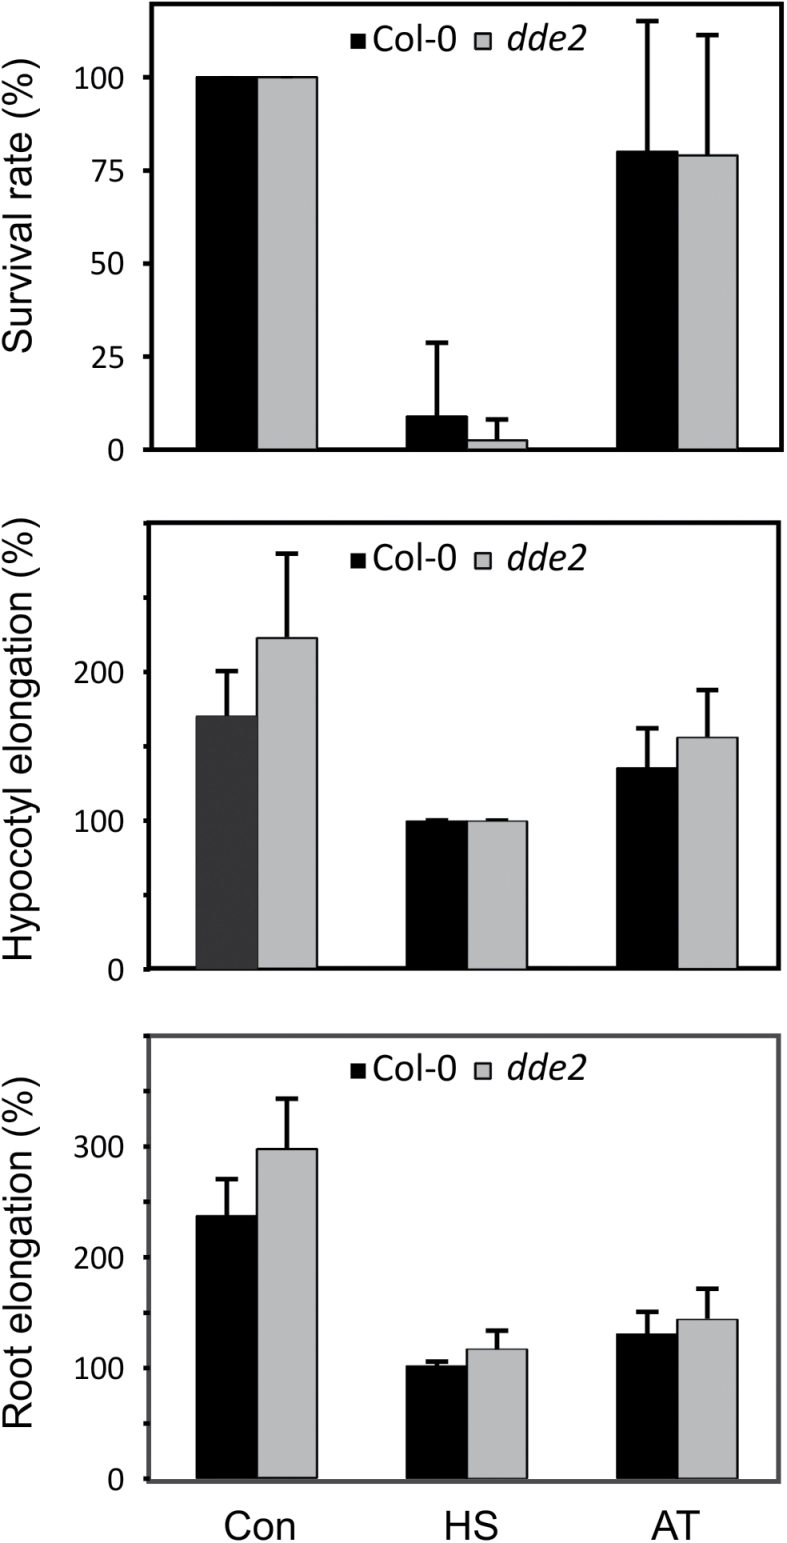
Standard acquired thermotolerance assays. Wild-type (black bars) and dde2 mutant (grey bars) seedlings were grown on agar plates at 22 °C. Seedlings were left at 22 °C (Con), treated with a heat shock at 45 °C for 2 h without prior acclimation (HS) or pretreated at 37 °C for 2 h followed by 2 h at 22 °C to acquire thermotolerance before receiving the heat shock at 45 °C for 2 h (AT). After the heat treatments, seedlings were returned to 22 °C. Survival, as judged by the ability of the seedlings to develop green leaves, was determined 5 d after the heat treatment. The hypocotyl and root length determined before the treatments was set to 100% and compared with the length of these organs 5 d after the treatments.